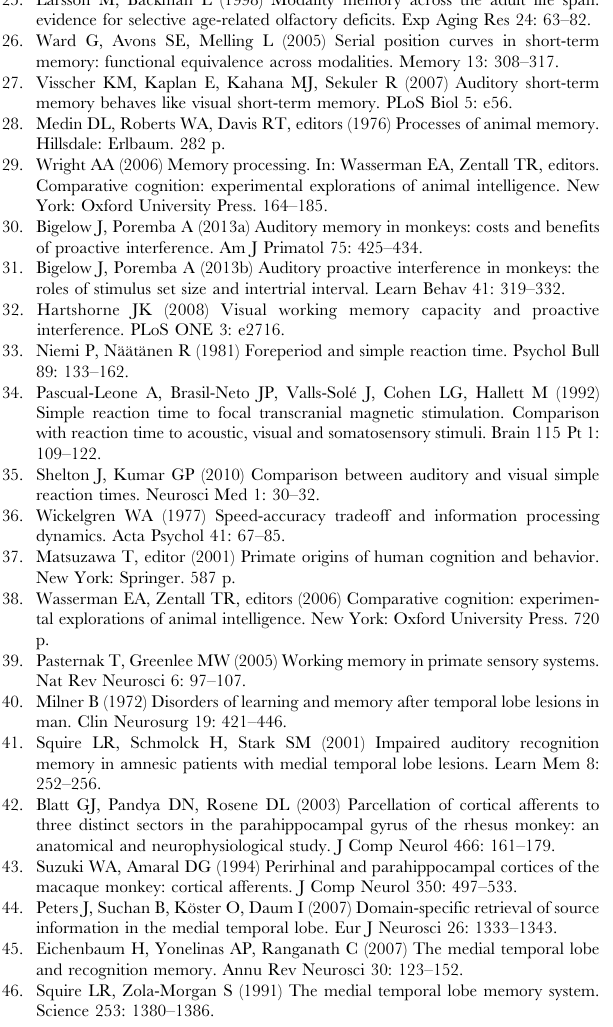
presented through headphones, tactile stimuli (middle two columns) comprised physical objects that the subjects touched and handled, and visual stimuli (right two columns) comprised 5-s silent videos presented on an LCD monitor. Stimulus names are those used for the object identification task described in Methods section of Experiment